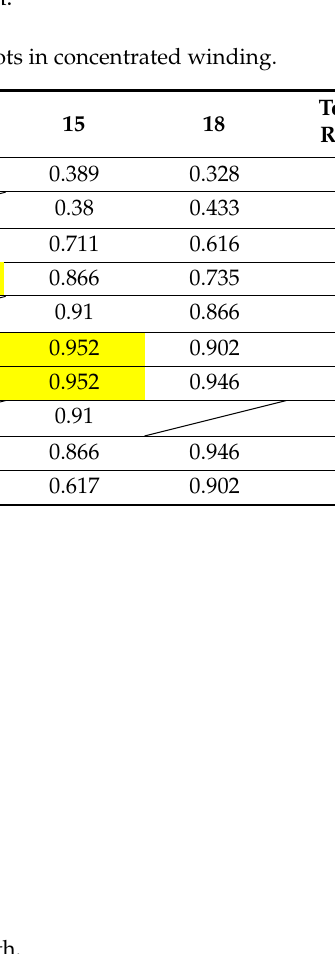
Figure 12. S lot cross-section. Next, the tooth cross-section is examined. As mentioned in Section 2, the magnetic loading also changes with the change of the tooth cross-section area, so the tooth cross- section is not an independent parameter. Therefore, the relationship between the tooth cross-sectional area and the shape of the magnet is freely determined in each model. How- ever, the overhang of the magnet shall be 0 mm. Additionally, to be independent of the number of coil turns, the ampere turn is constant, and the torque characteristics with re- spect to tooth cross-sectional area are calculated. Figure 13 shows the change in torque due to the effect of the tooth cross-sectional area, with the horizontal axis being the slot width. It is normalized based on the torque when the slot width is 2.0 mm in 10p9s, which has the largest tooth cross-section. The torque increases as the slot width are narrower because the magnet shape is changed by the stator shape, which increases the amount of magnet used. Thus far, the number of coil turns and the tooth cross-section, which varies with the slot width, have been examined. Finally, torque with respect to slot width is shown in Figure 14. It is calculated by the product of the number of coil turns and torque with respect to the tooth cross-sectional area. It is considered that the number of coil turns ( N ) affects the torque in the first study in Figure 11. In the next study of the tooth cross- sectional area, the magnet flux 𝜙 due to the change in magnet shape accompanying the change in stator shape affects the torque, and the difference in the number of pole pairs